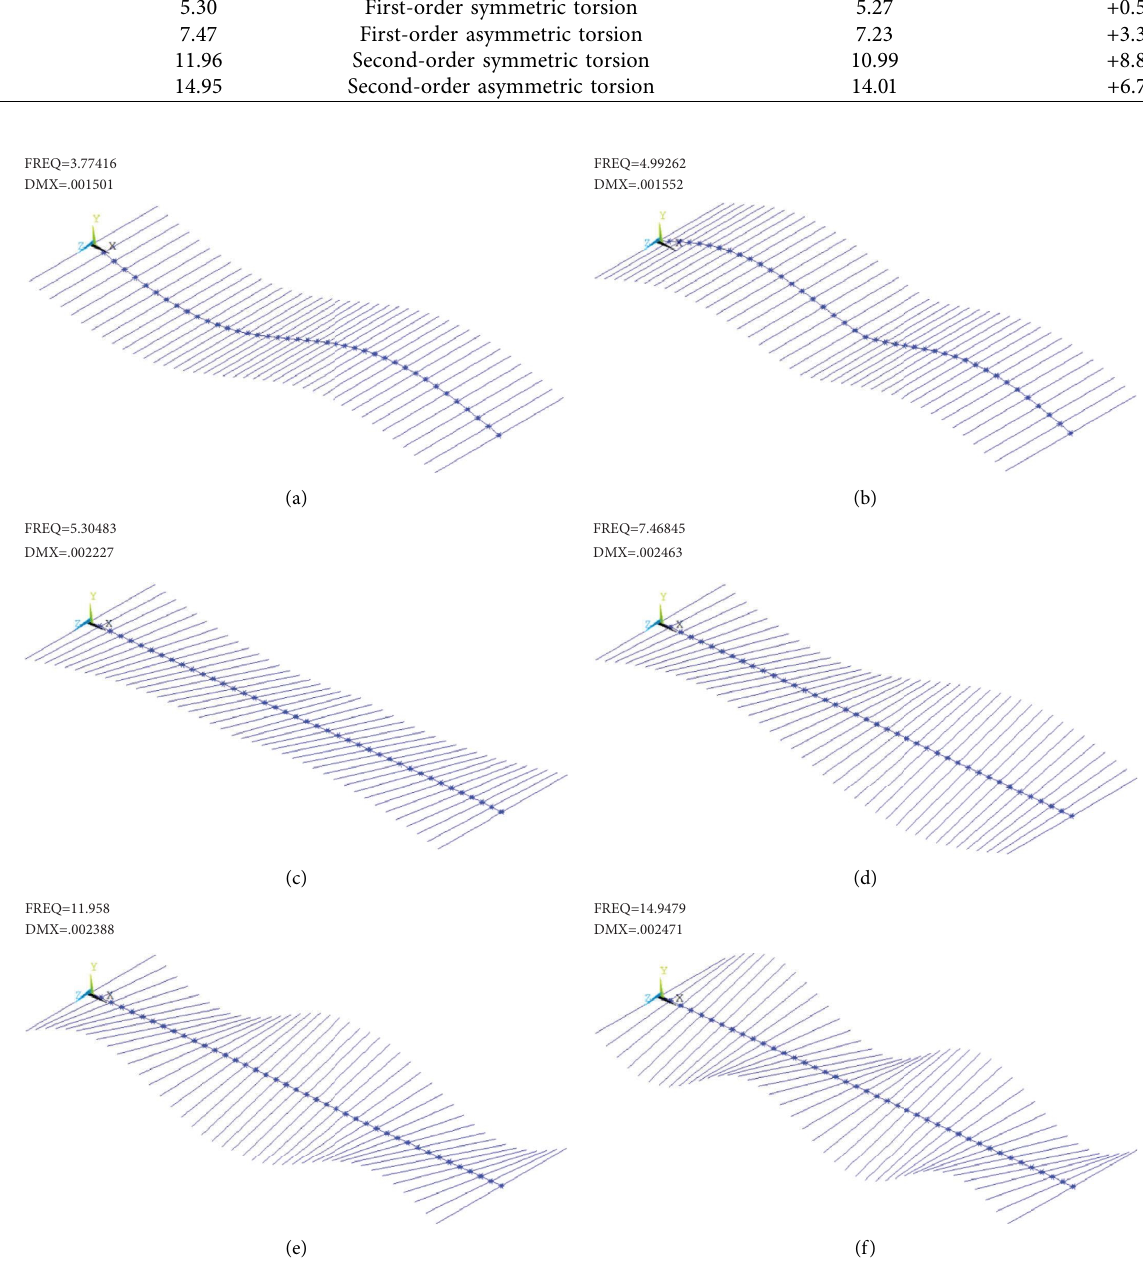
Figure 3: Calculated mode shape of the initial fnite element model. (a) First-order asymmetric vertical bending (3.77Hz). (b) First-order symmetric vertical bending (4.99 Hz). (c) First-order symmetric torsion (5.30 Hz). (d) First-order asymmetric torsion (7.47 Hz). (e) Second- order symmetric torsion (11.96Hz). (f) Second-order asymmetric torsion